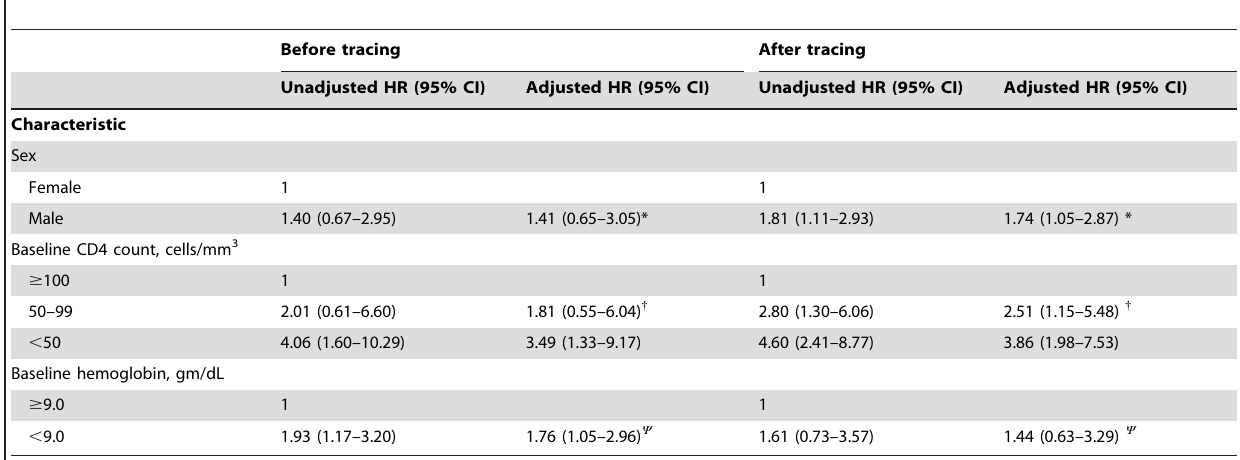
Table 3. Hazard ratios for death before and after tracing after initiation of HAART in the IDCC, Gaborone, Botswana.